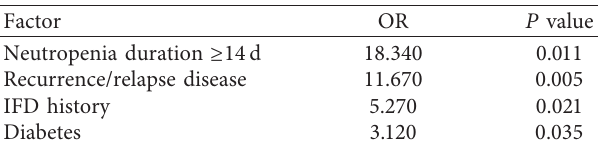
Table 7: Multivariate analysis of risk factors for invasive fungal infection.